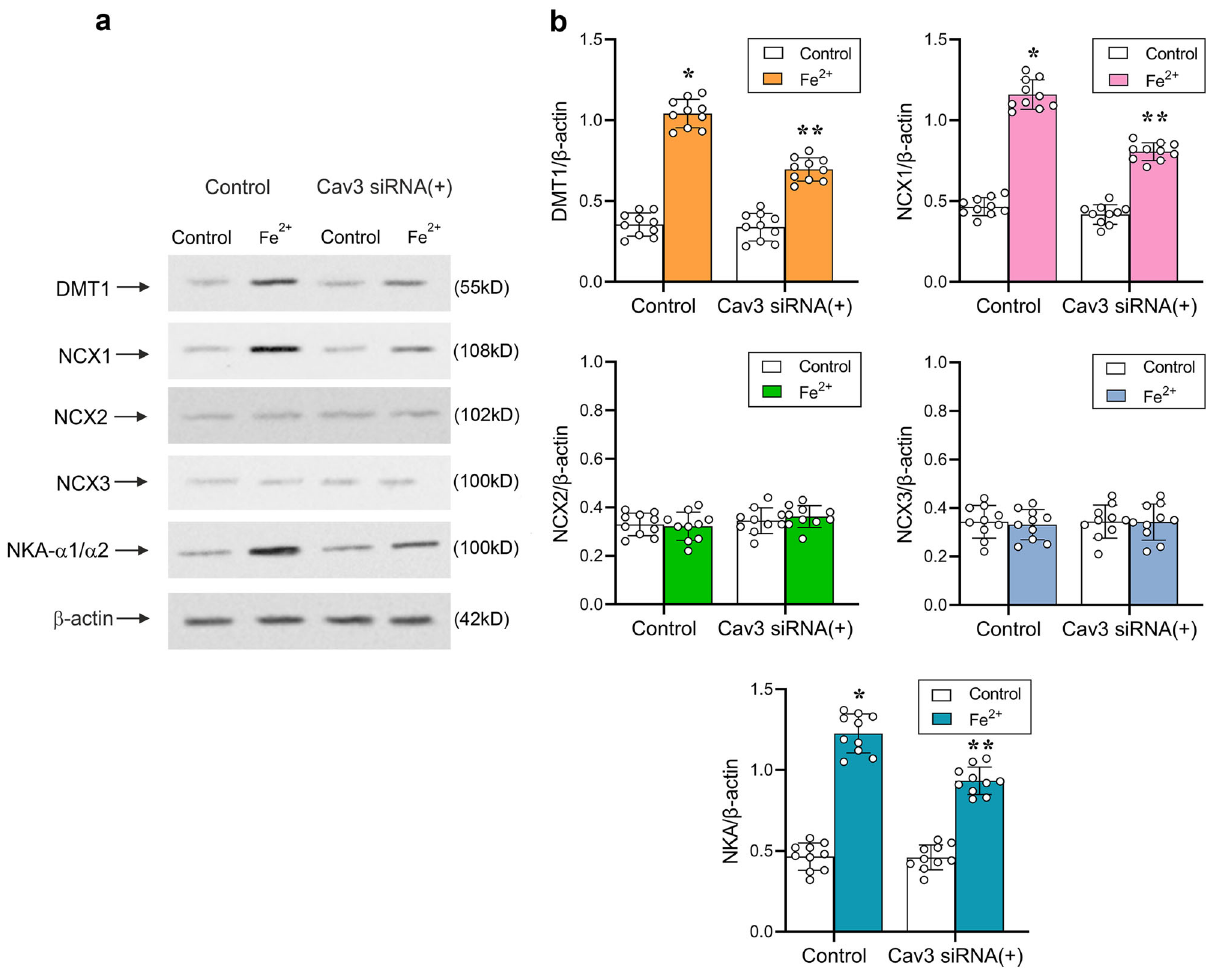
Fig. 5 Caveolae integrate DMT1, NKA and NCX. a Representative protein western blot bands for DMT1, NCX1-3 and NKA- α 1/ α 2 in caveolae membranes extracted from cultured astrocytes. Astrocytes were treated with sham (Control), with siRNA negative control ( − ) or with Cav3 duplex chains (siRNA( + )) for 3 days. b Protein levels are shown as the ratio of DMT1 (55 kDa) and β -actin (42 kDa), NCX1 (108 kDa) and β -actin, NCX2 (102 kDa) and β -actin, NCX3 (100 kDa) and β -actin, NKA- α 1/ α 2 (100 kDa) and β -actin (42 kDa). Data represent mean ± SD, n = 6. *Indicates statistically signi fi cant ( p < 0.05) difference from any other group; **indicates statistically signi fi cant ( p < 0.05) difference from control plus Fe 2 + group or Cav3 siRNA( + ) plus Ctrl